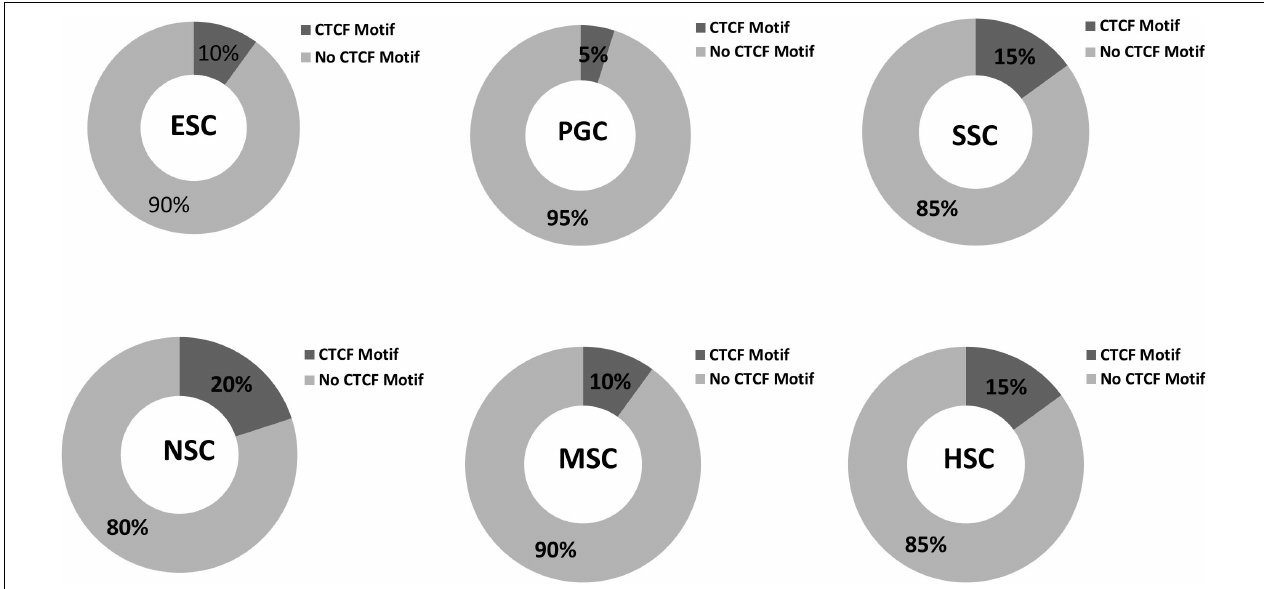
FIGURE 10 | CTCF binding sites in respective stem cell hub genes. The occupancy rates of the CTCF binding motif among the 20 hub genes within the respective stem cell specific modules. Dark gray shading indicates the percentages of CTCF binding motif among the 20 hub genes in the six stem cell types. Light gray corresponded to non- CTCF binding